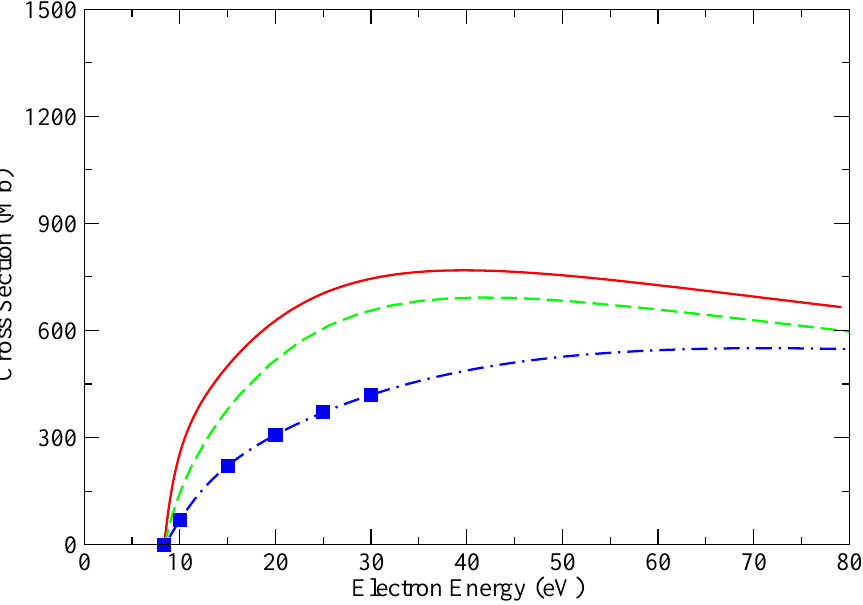
Figure 5. Electron-impact direct ionization of W from the 5 d subshell. Solid line (red): semi-relativistic distorted-wave cross section, dashed line (green): fully-relativistic distorted-wave cross section, dot- dashed line with solid squares (blue): TDCC cross section (1.0 Mb = 1.0 × 10 − 18 cm 2